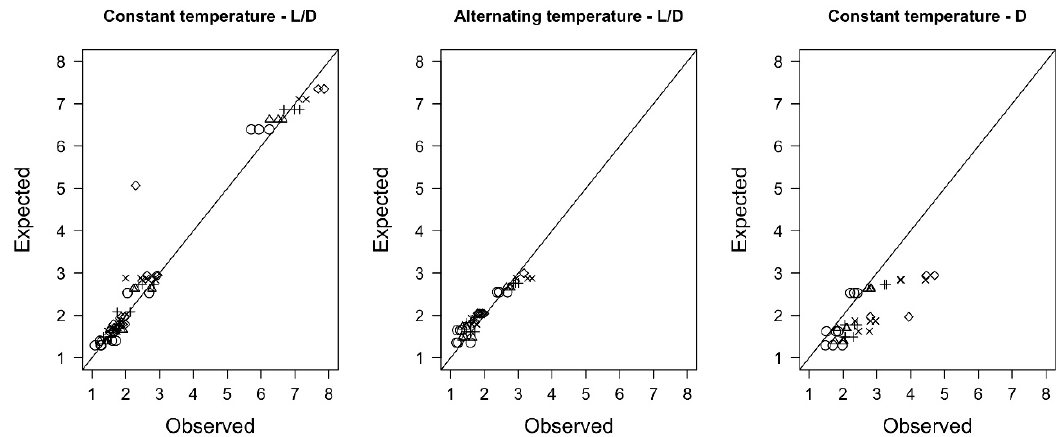
Figure 4. Germination times for the 10 th (circle), 20 th (triangle), 30 th (cross), 40 th (multiplication sign) and 50 th (diamond) percentiles. Observed values in all dishes and predictions with Equation (3) and the parameters in Table 4 at different temperature (constant, alternating) and light (alternating light/dark, L/D and complete darkness, D) regimes.